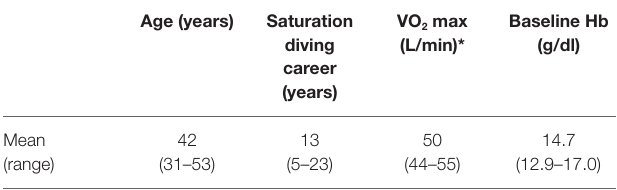
TABLE 1 | Study subject characteristics ( n =